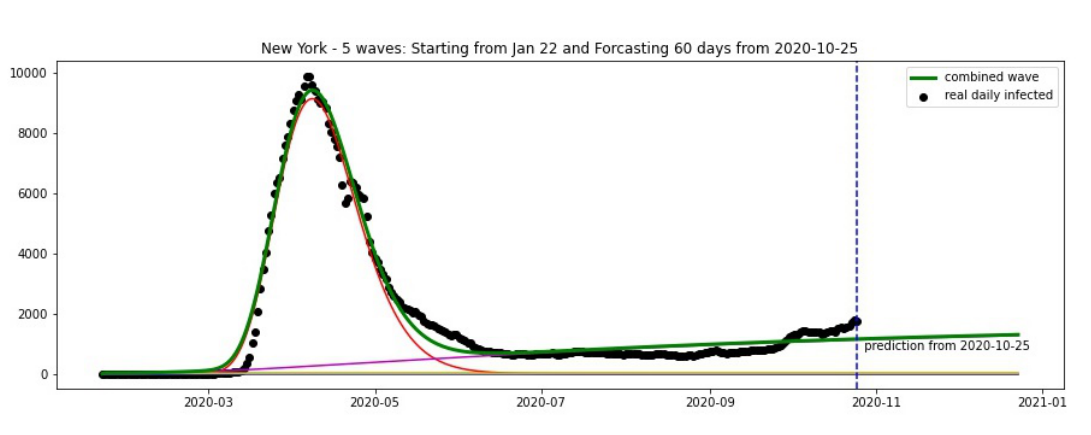
Figure 16. Florida: fitting and forecasting from 25 October. The green curve is the combination of other curves which are EF wavelets.